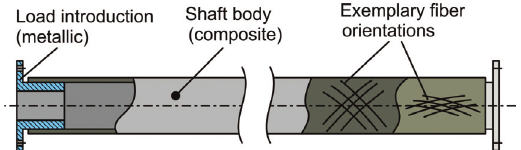
Figure 1 General design of a composite metal hybrid driveshaft.